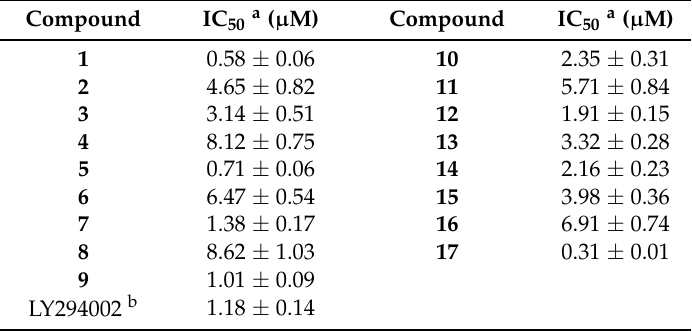
Table 4. Inhibitory Effects of Compounds 1 − 17 a on the Invasion of MDA-MB-231 Cells. Compound